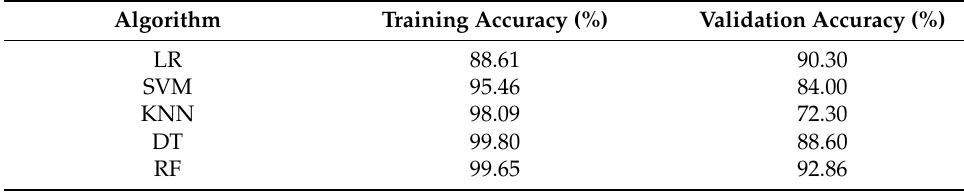
Table 1. AL selection model training and validation accuracies.